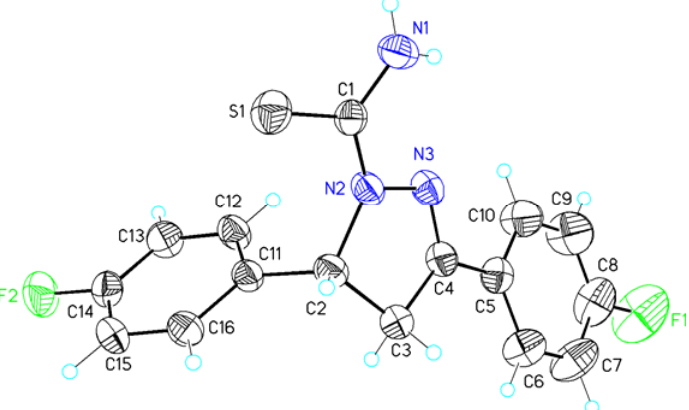
Figure 3. Molecular structure of 2 showing the atom labeling scheme and 50% probability displacement ellipsoids.